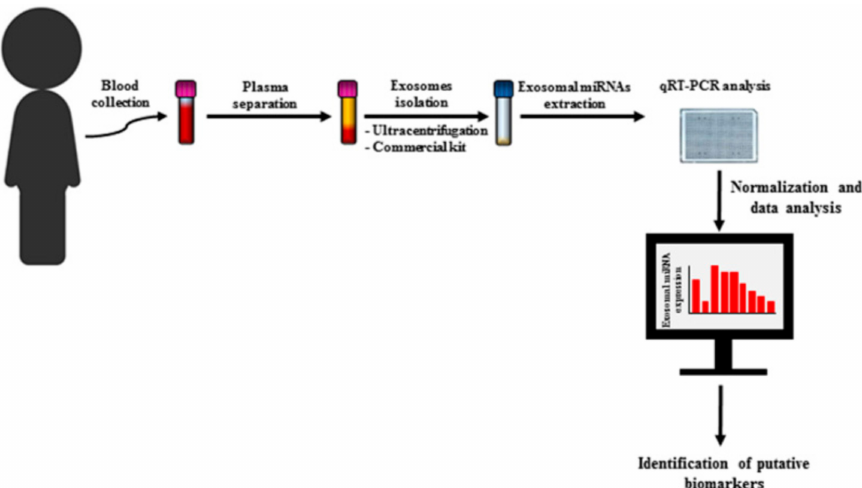
Figure 1. Identification of exosomal miRNAs as biomarkers in pediatric cancer: Exosomal miRNAs display di ff erent expression patterns between cancer patients and healthy children. Moreover, their expression changes during disease progression and after therapy and can therefore be promising biomarkers. With a simple venipuncture, the blood sample is collected and processed to separate the plasma or serum through serial centrifuges. Exosomes from serum or plasma are then isolated by ultracentrifugation or by using commercial kits. The exosomes pellet is lysate, and RNA is extracted. After retro-transcription, miRNA expression is assessed by real-time PCR and the data obtained is analyzed with specific software for identification of statistically deregulated miRNAs which may have a possible role as